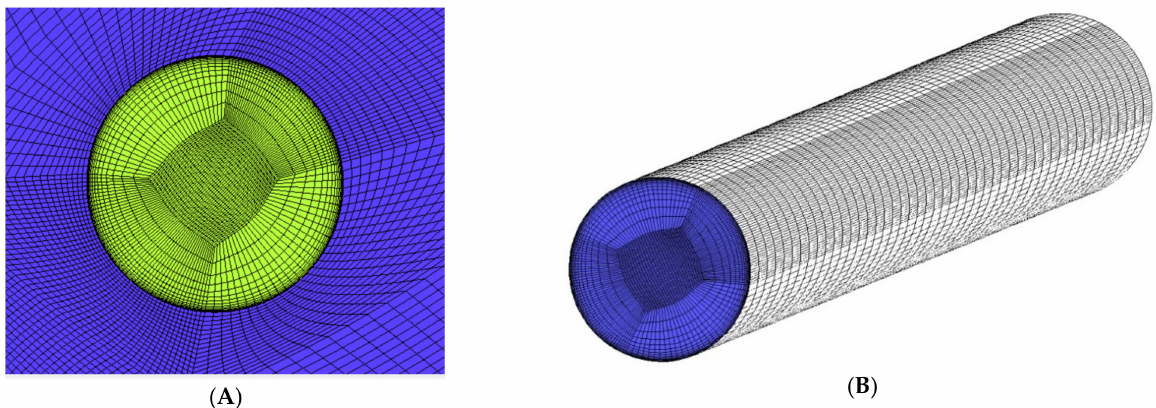
Figure 5. Mesh refinement of the first cooling hole, ( A ) inlet view, ( B ) interface view.